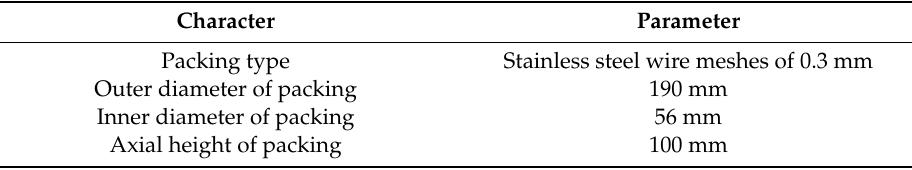
Table 1. The equipment parameters of the cross-flow rotating packed bed (CF-RPB).